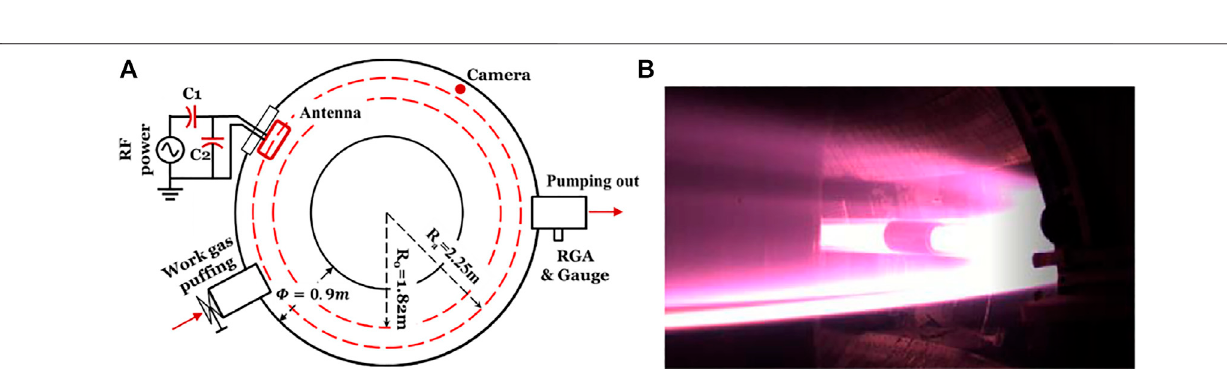
Frontiers in Physics |